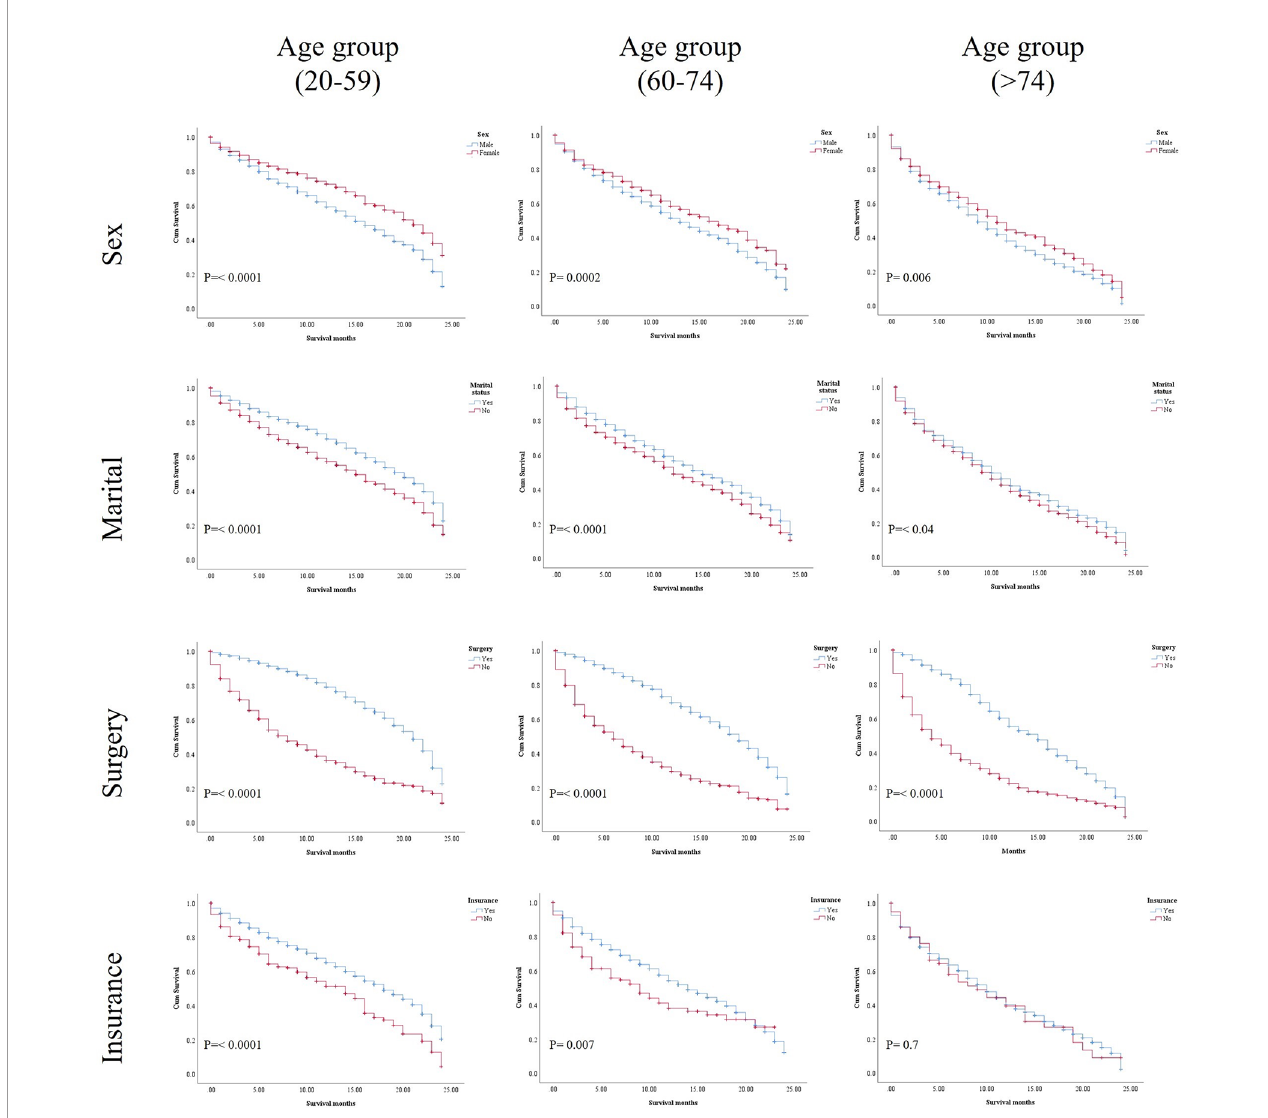
FIGURE 3 | Kaplan – Meier (KM) results of the age groups in the ICI era for the selected variables: sex, marital status, surgery status, and insurance status.